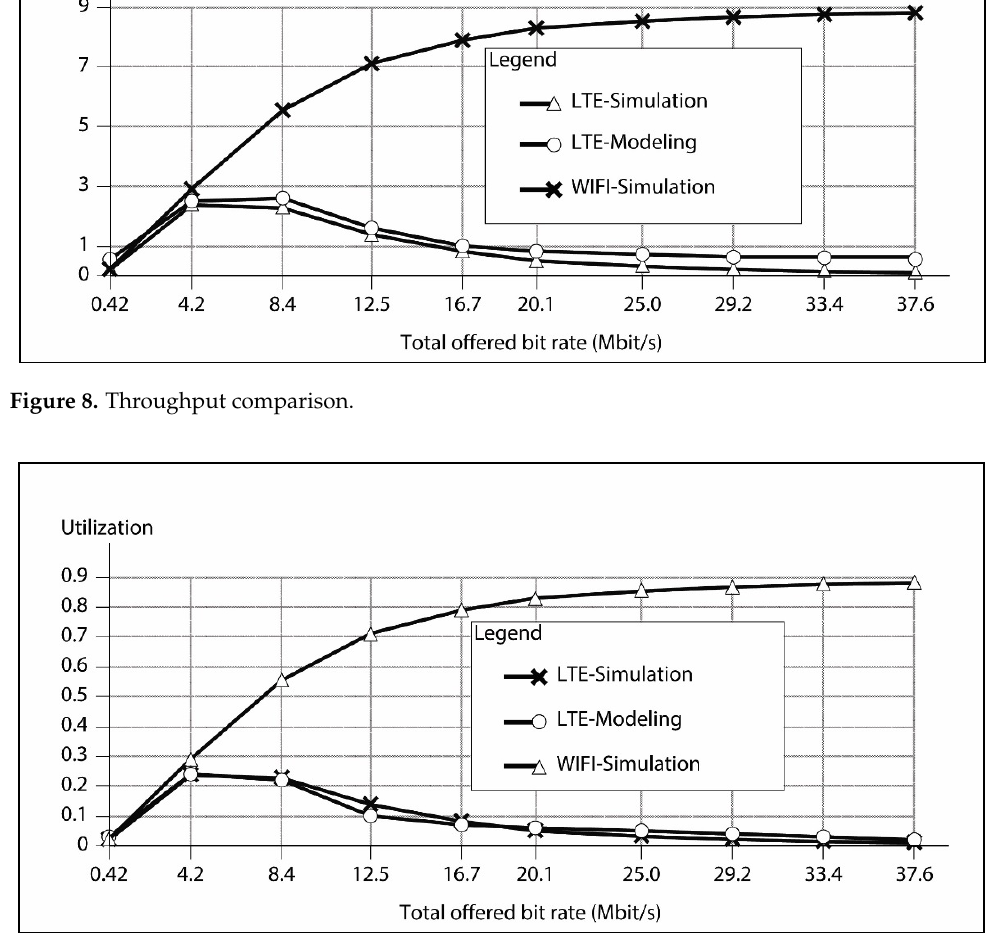
Figure 9. Utilization comparison.